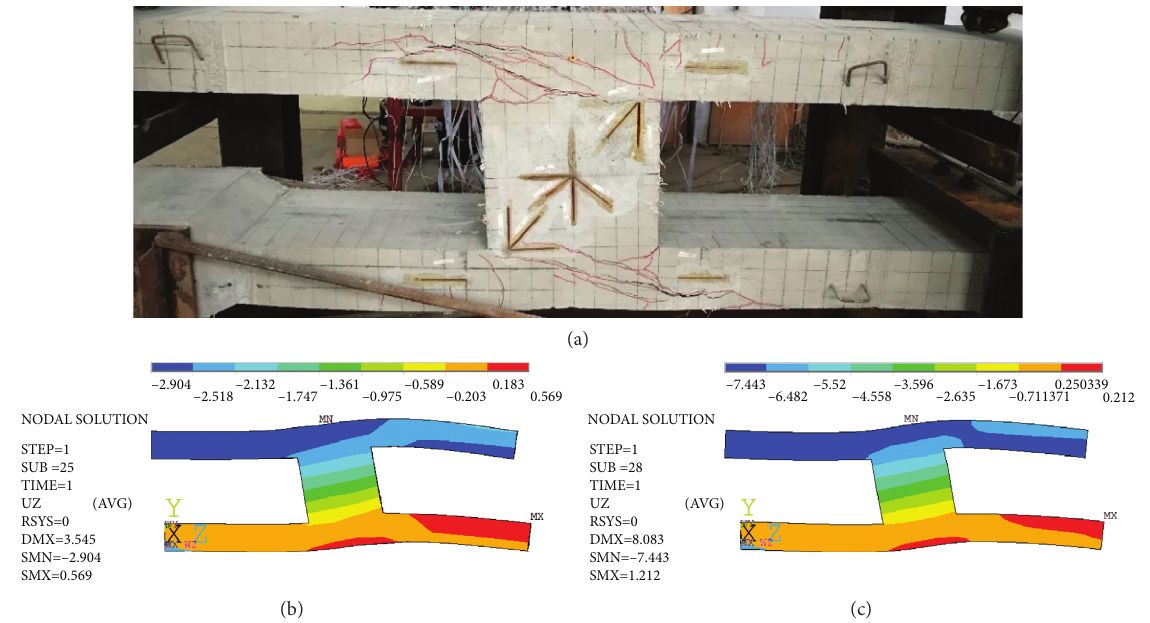
Figure 31: Deformation diagram. (a) Test deformation diagram. (b) Deformation diagram of FE3 under failure mark 1. (c) Deformation diagram of FE3 under failure mark 2.